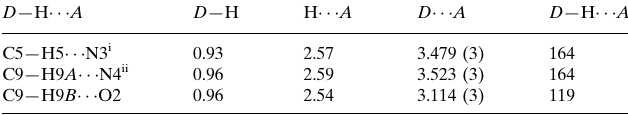
Hydrogen-bond geometry (A˚ , (cid:2)